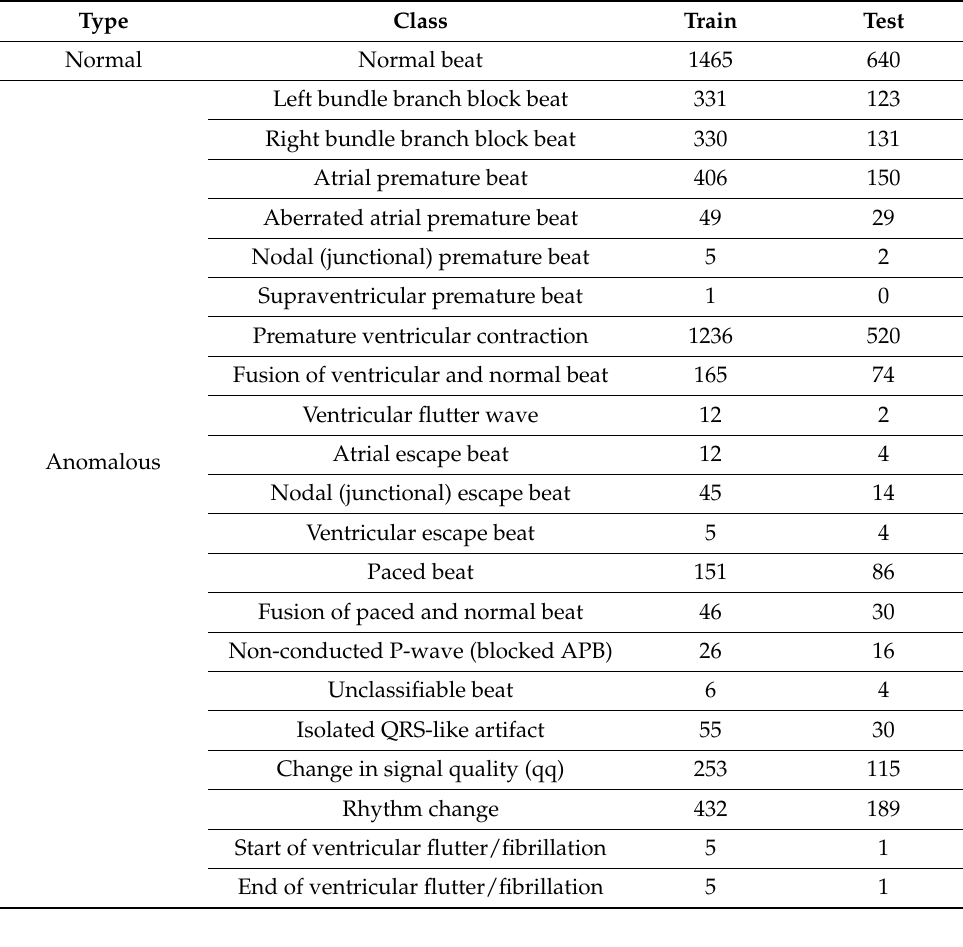
Table 3. ECG segments for each ECG class in train and test sets for the first experimentation. Since our goal is to detect any kind of anomaly, we considered both rhythm and beat alterations with no difference. We also considered signal related annotations since a low quality noise signal could represent an issue to medical diagnosis.